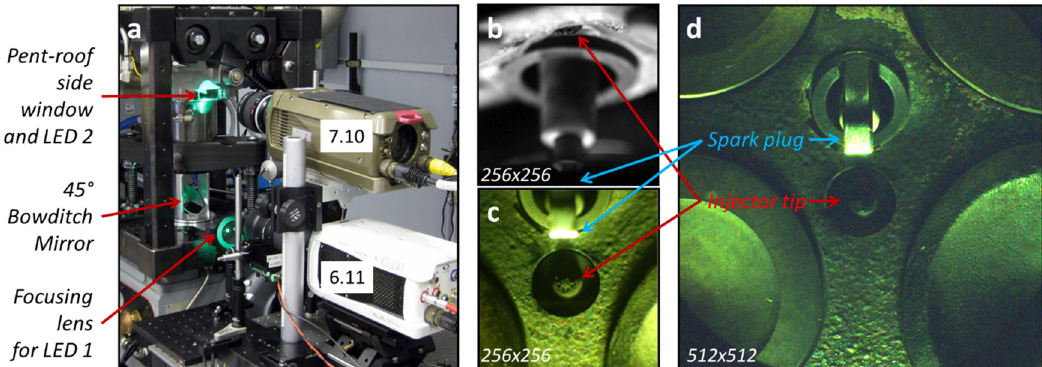
Figure 3. ( a ) Optical experimental setup and ( b , c ) reference images that correspond to the dual-camera spray imaging and ( d ) to the combustion process imaging.